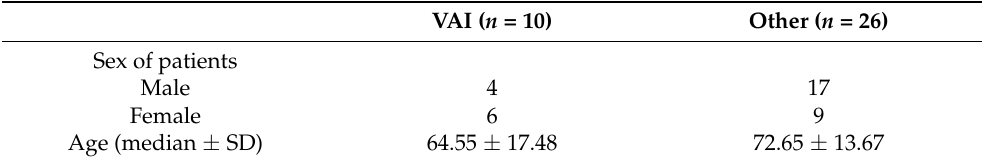
Table 1. Clinical demographics of patients with Burkholderia cepacia complex (BCC) infections.